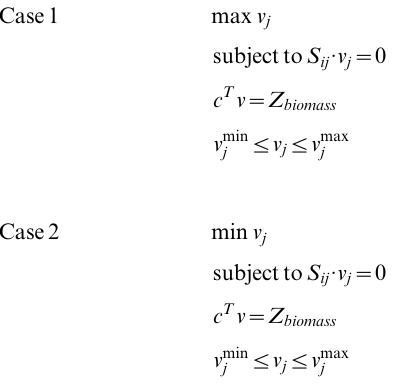
Figure 6. Flux distribution for S.cerevisiae obtained using artificial hit and run sampling. Individual flux distribution histograms are along the diagonal and pairwise scatter plots are off-diagonal. The off-diagonal scatter plots show the relationships between fluxes through two reactions. The red, blue and magenta rectangular boxes were made to compare the correlation patterns in wild type model, engineered cofactor imbalanced model and the engineered cofactor balanced model.